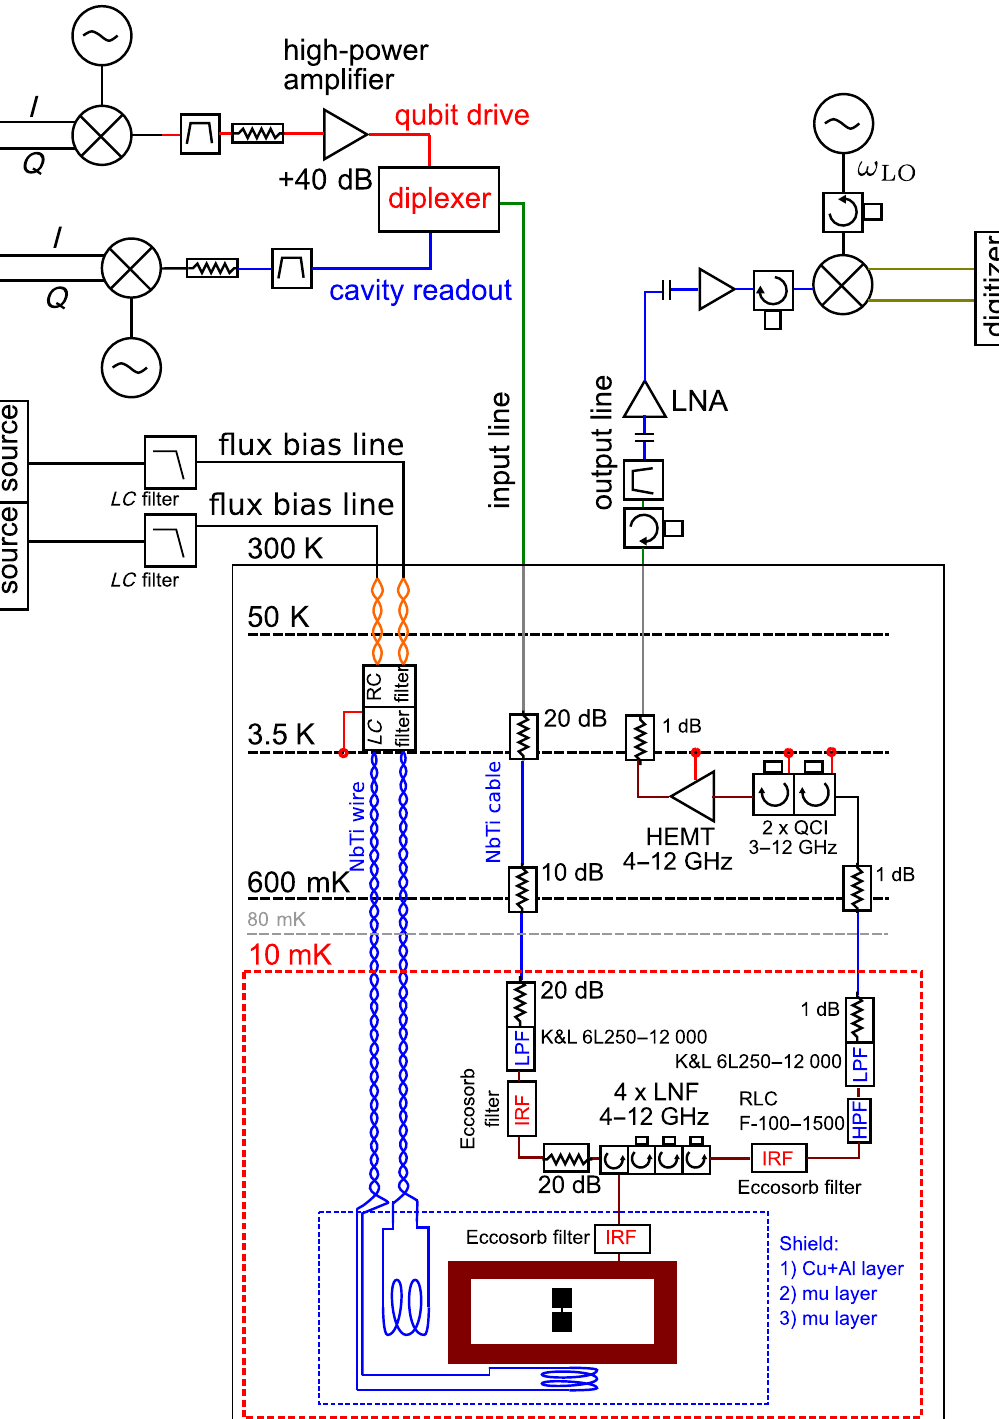
FIG. 8. Schematic of the measurement setup. Here, acronyms AWG, IRF, LPF, LNA stand for an arbitrary waveform generator, an infrared filter, a low-pass filter, and a low-noise amplifier, respectively. QCI corresponds to a QuinStar QCI isolator. = 1 + 1 ( P ( S 1 ) − P ( S 2 ) ) . (F4) The data shown in Figs. 4(a) and 4(b) are processed using P 1 1 1 2 2 the described